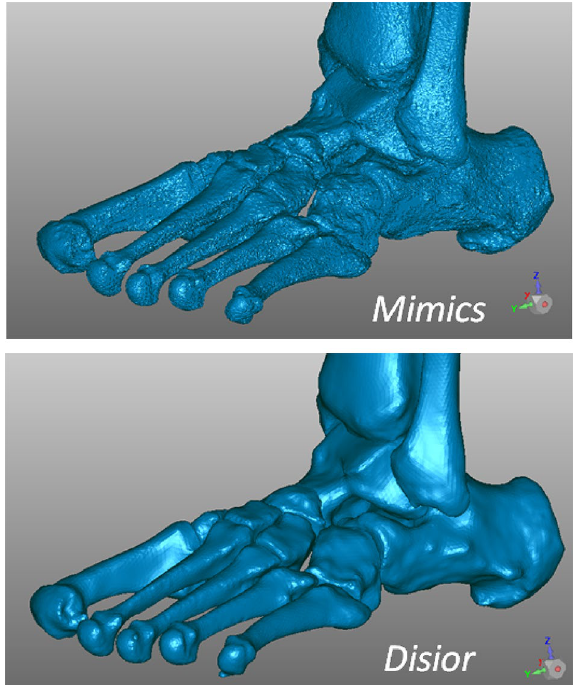
Figure 2. Triangular meshes resulting from the 3D reconstruction of bone models of the same flatfoot, software screenshots from a typical patient of the present study: by using MIS (top) and DIS (bottom). These include distal tibia and fibula and all foot bones but phalanges and sesamoids. The number of points and triangles were respectively 1.137.013 and 2.273.950 in MIS, 140.728 and 281.400 in DIS; the size of the corresponding files was 108 MB in MIS, 13.5 MB in